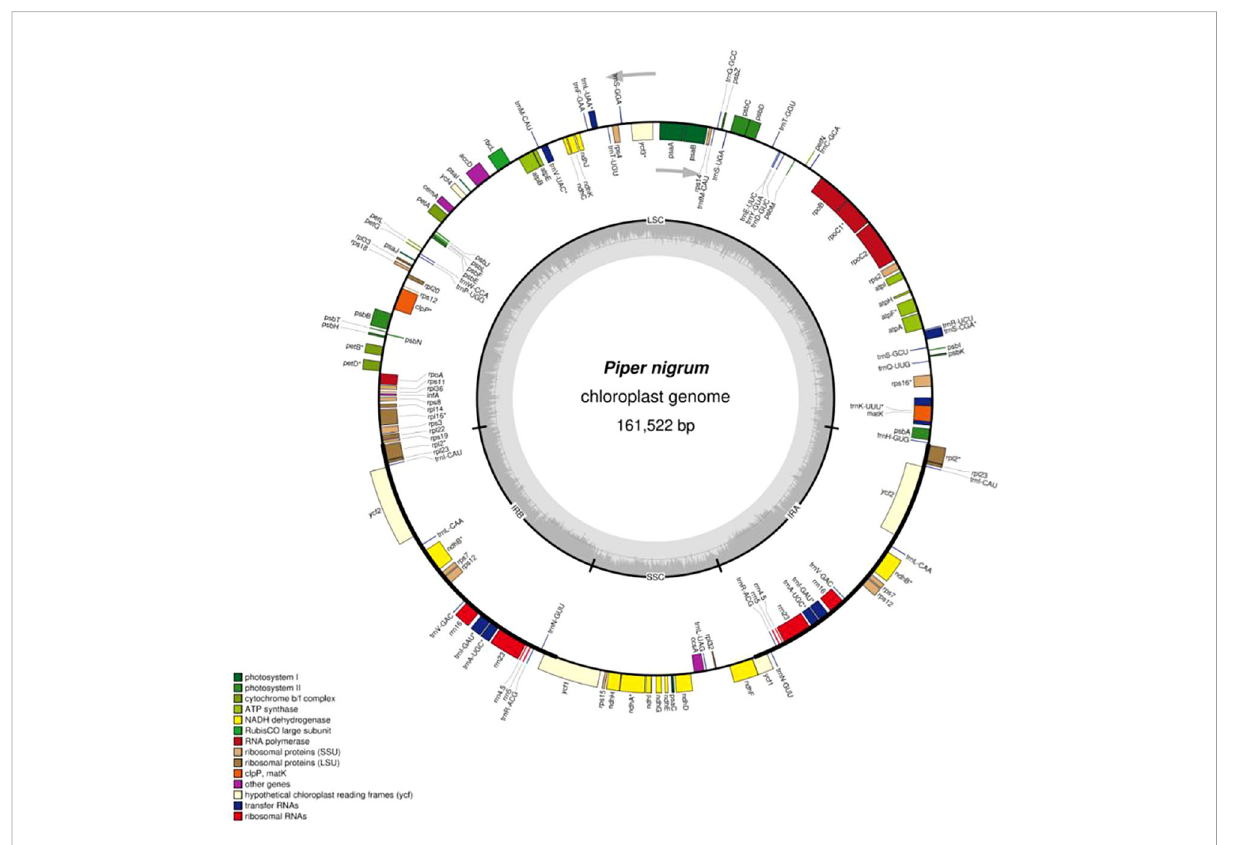
FIGURE 1 Circular map of the Piper nigrum chloroplast